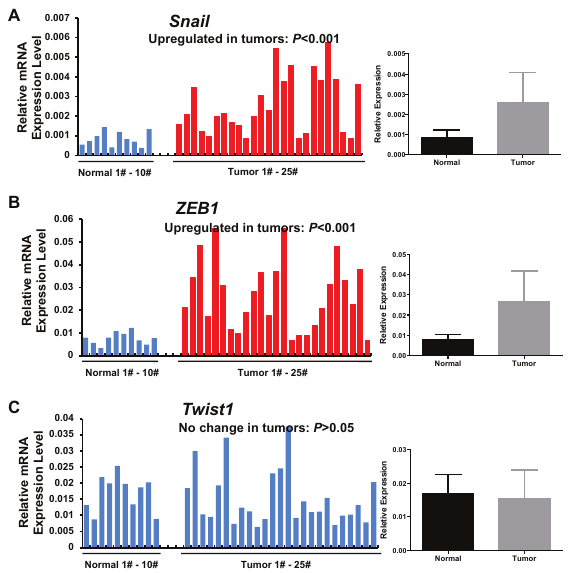
Figure 3: Snail, ZEB1 and Twist1 expression in adenocarcinoma of esophagogastric junction tissue samples